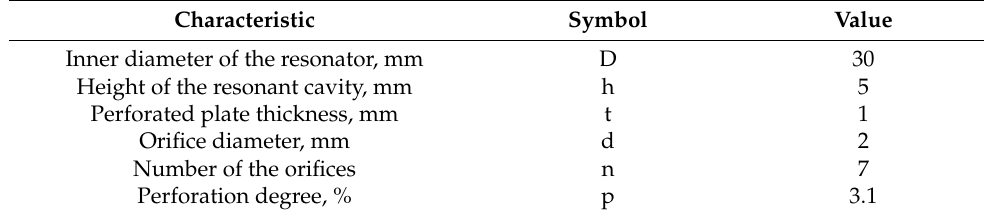
Table 1. Geometry of the resonator under